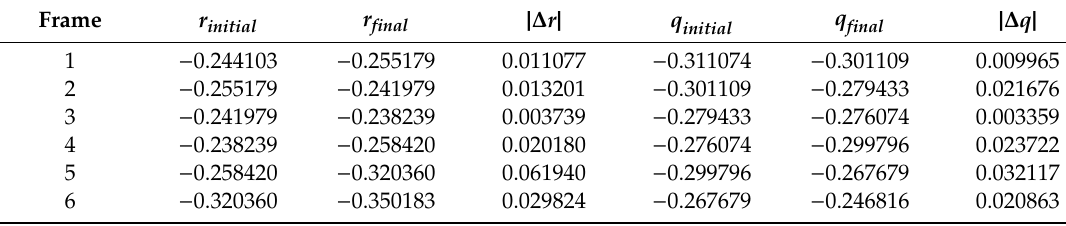
Table 2. The adaptive initial method’s updating principle of r and q